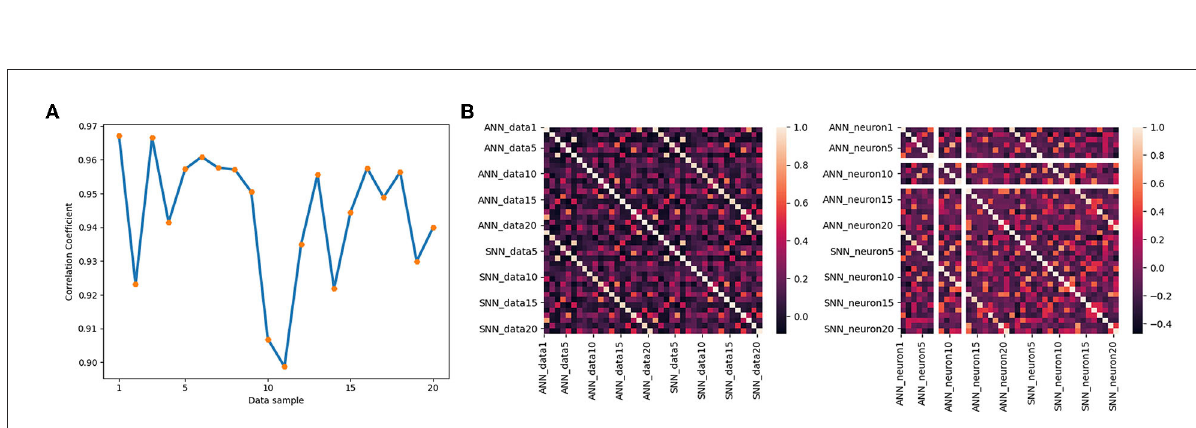
FIGURE12 (A) Correlation of the output of the two models for different data. (B) The correlation coefficient matrix along data dimension (left) and neuron dimension (right).